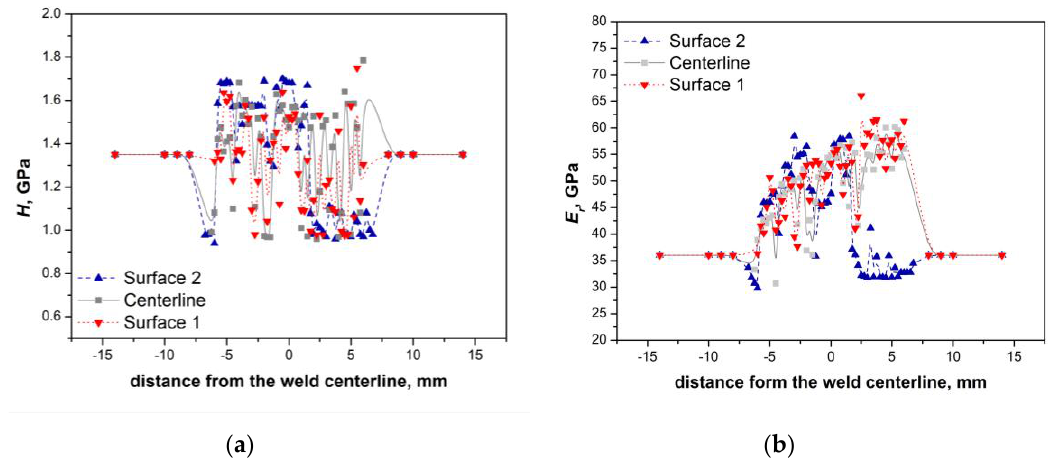
Figure 8. ( a ) Nanoindentation hardness and ( b ) nanoindentation Young’s modulus along different profiles of the cross-section of DS-FSW joints (Surface 1: 10 μm from the top surface of joint; centreline: at a middle height of thickness sample; Surface 2: at 10 μm from the bottom surface of joint).